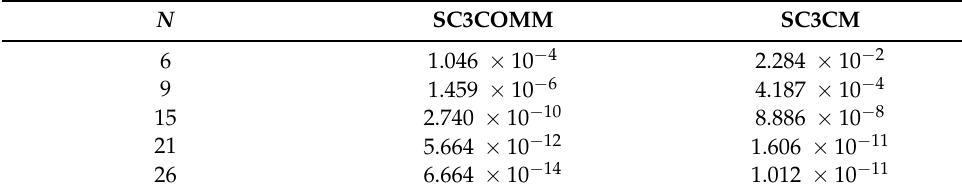
Table 3. Maximum absolute error of Example 3.